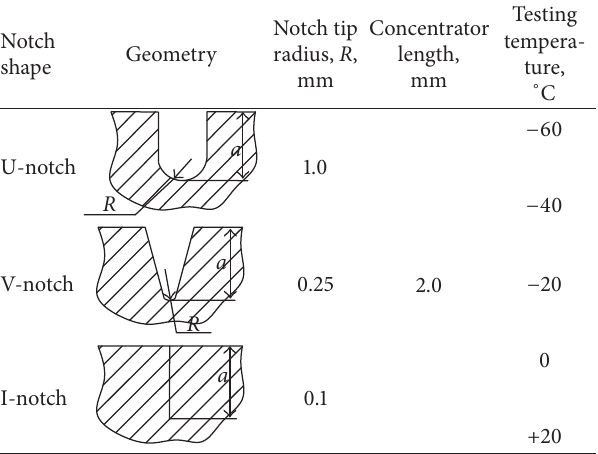
Table 1: Impact test conditions for 17Mn1Si steel specimens. Notch shape